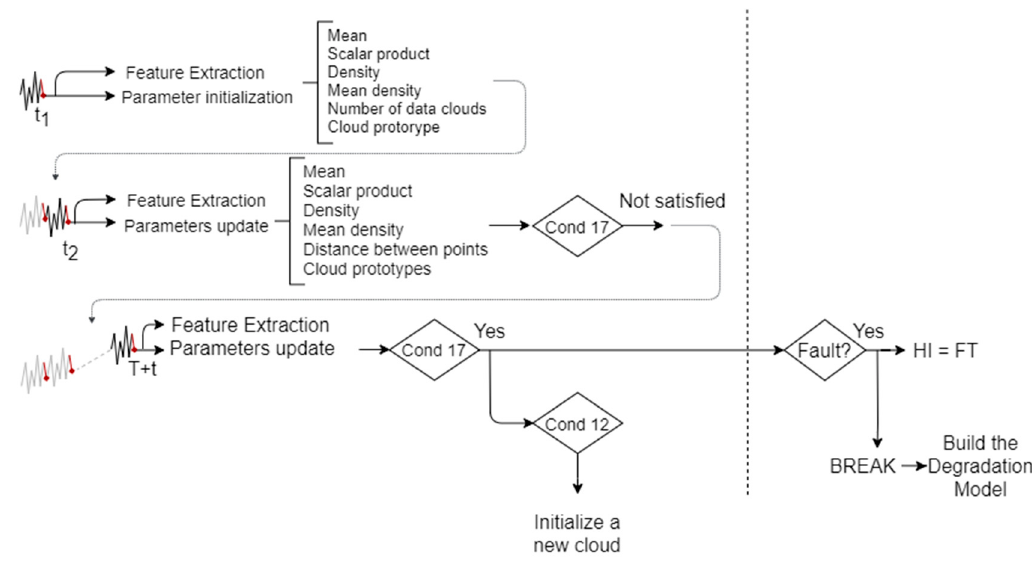
Figure 5. Example of the implementation of the proposed methodology for the first data.